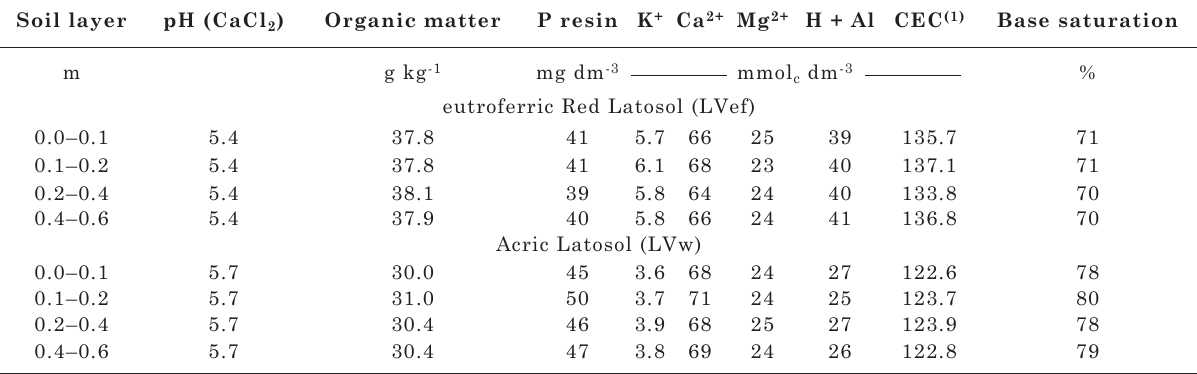
table 1. Soil chemical properties prior to the experiment Soil layer ph (cacl 2